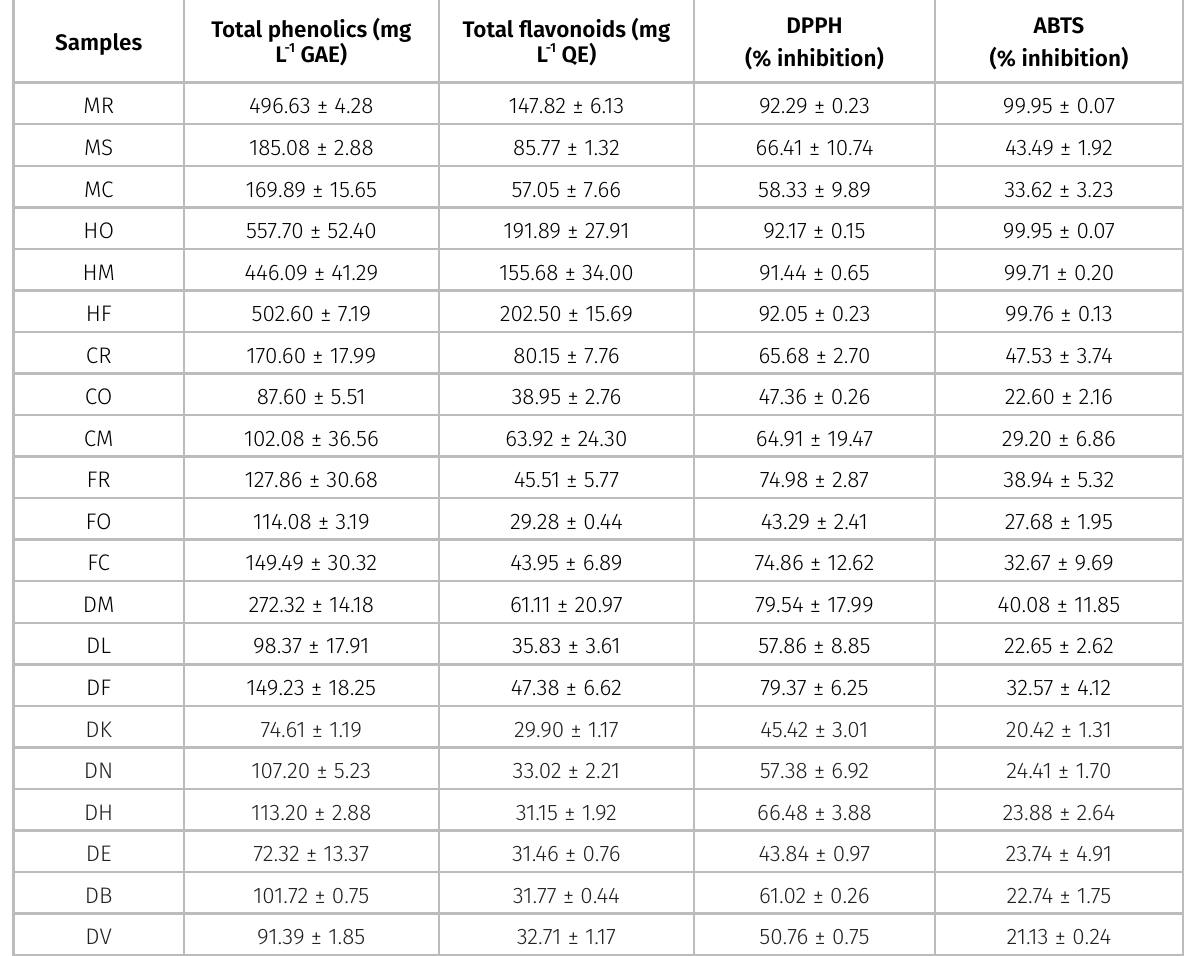
M: lemon balm; H: Peppermint; C: lemon grass; F: fennel; D: anise. The second letter of the sample acronym distinguishes the brand. Mean ± standard deviation, n =